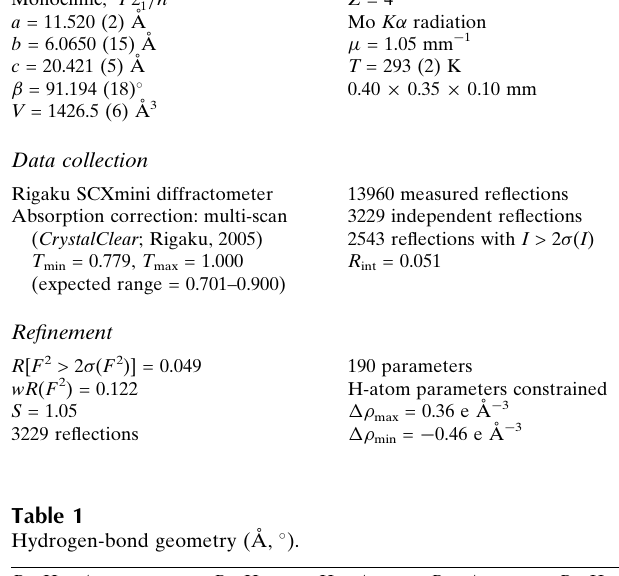
Rigaku SCXmini diffractometer Absorption correction: multi-scan ( CrystalClear ; Rigaku, 2005) T min = 0.779, T max = 1.000